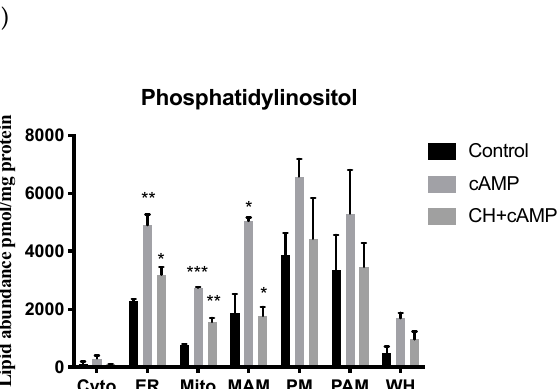
Figure 4. Lipid distribution profiles in subcellular fractions. Lipid abundance in cytosol (Cyto), endoplasmic reticulum, (ER), mitochondria (Mito), mitochondria-associated membrane (MAM), plasma membrane (PM), and plasma membrane- associated membrane (PAM) fractions, as well as whole cell extract (WC) from the control, dbcAMP-treated, and dbcAMP plus cycloheximide-treated MA-10 cells. ( A ) Total lipids, ( B ) phosphatidylcholine, ( C ) sphingomyelin, ( D ) phosphatidic acid, ( E ) phosphatidylethanolamine, ( F ) phosphatidylserine, and ( G ) phosphatidylinositol. Data shown are the average of results for each molecular species, mean ± SEM; n = 4; * p < 0.05; ** p < 0.01; *** p < 0.001. Table 1. Overview of subcellular lipidome.